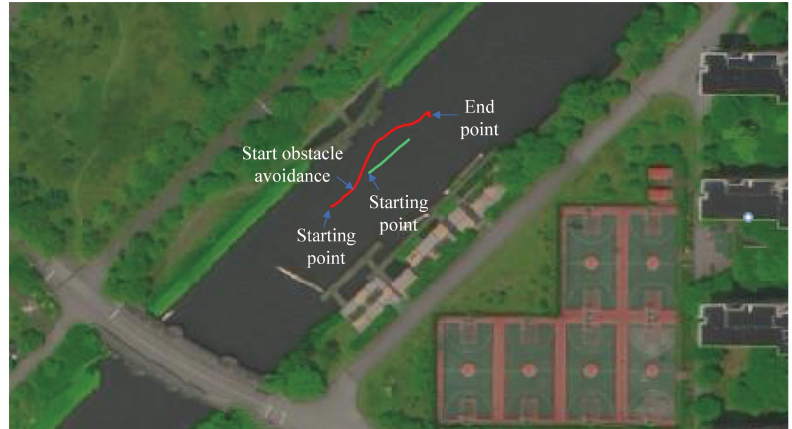
Figure 31. Crossing situation.